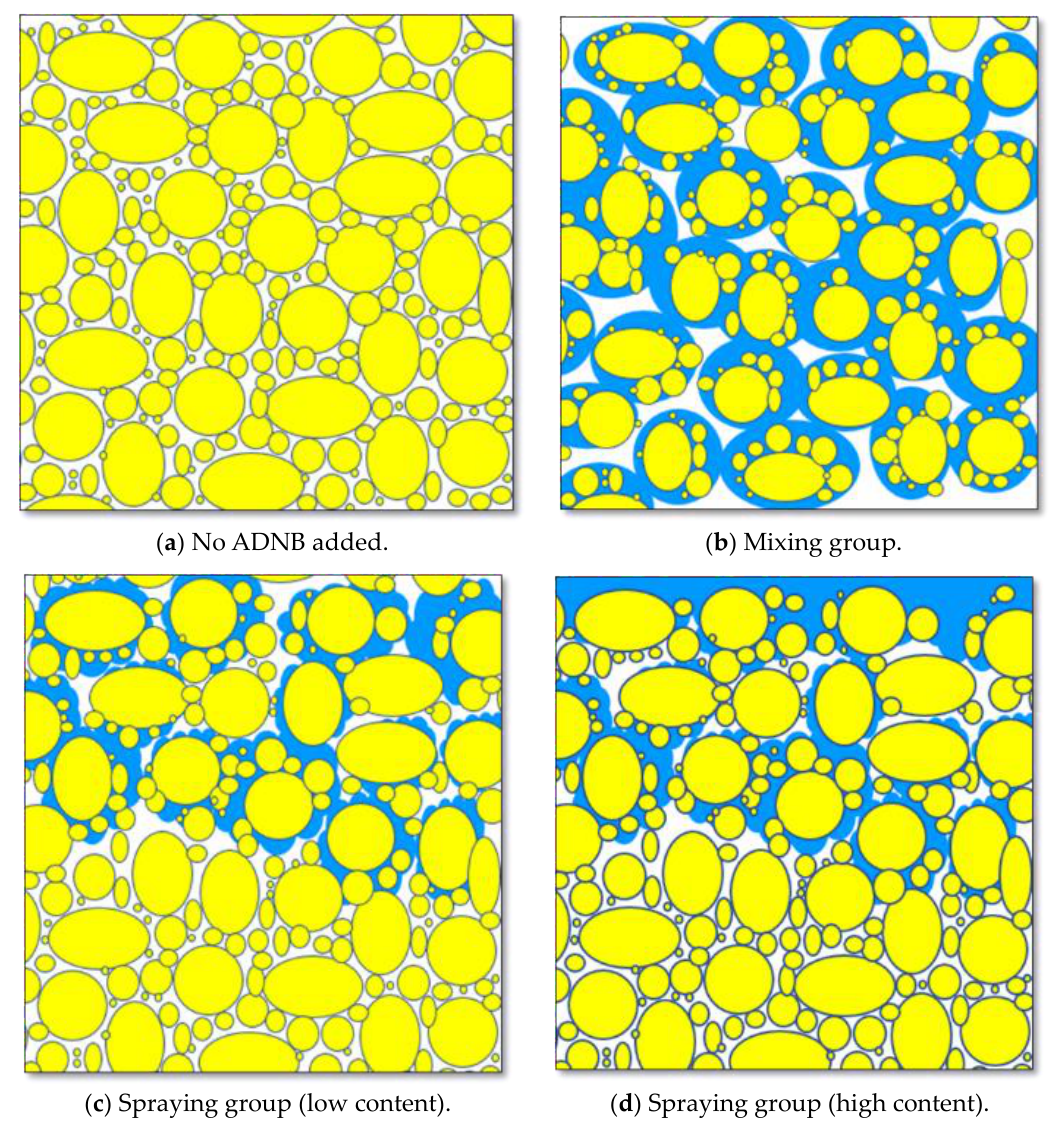
Figure 12. Schematic diagram of the sample structure in different processes.